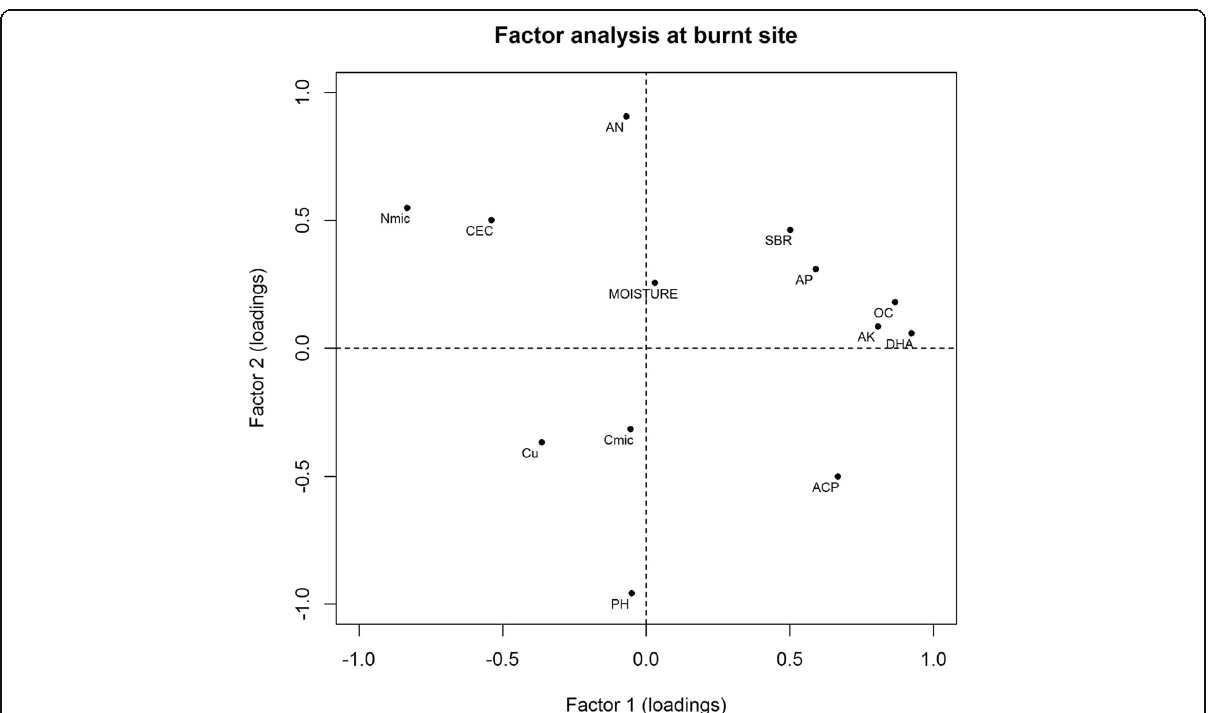
Fig. 5 Two factor components extracted from the variables for physicochemical and microbial properties of burnt sites of pine and oak forests ( C mic , soil microbial biomass carbon; N mic , soil microbial biomass nitrogen; SBR , soil basal respiration; DHA , dehydrogenase activity; ACP , acid phosphatase activity; OC , organic carbon; CEC , cation exchange capacity; AN , available nitrogen; AP , available phosphorus; AK , available potassium; Cu ,